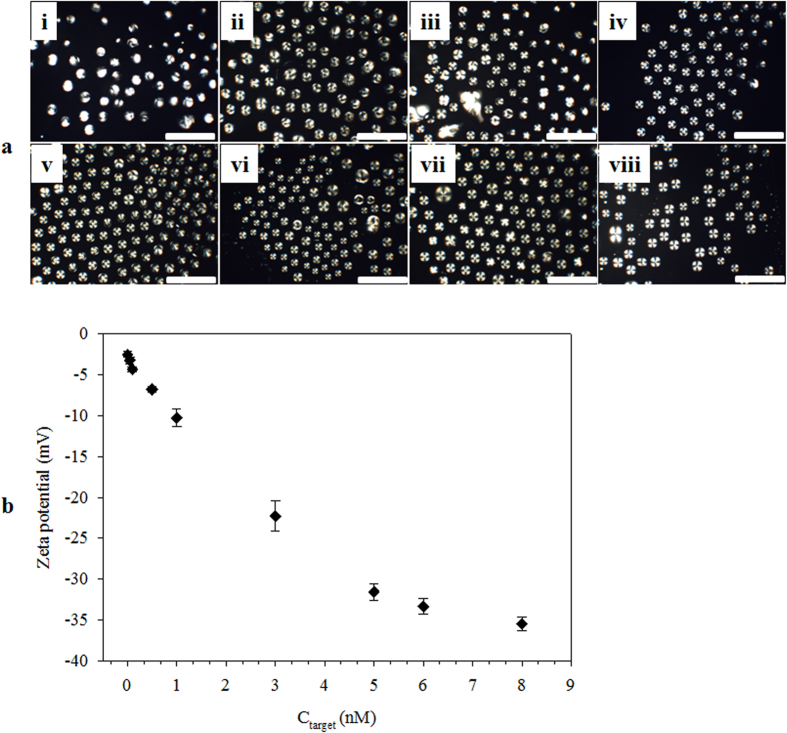
(a) Polarized optical microscopy images of the E7DTAB/DNAs droplets at ssDNAtarget concentrations (Ctarget) of (i) 0, (ii) 0.1, (iii) 0.5, (iv) 1, (v) 3, (vi) 5, (vii) 6, and (viii) 8 nM. The scale bars are 50 μm. (b) Zeta potential as a function of Ctarget. The error bars represent standard deviation. E7DTAB/DNAs, E7 droplets coated with dodecyltrimethylammonium bromide (DTAB) and ssDNAprobe.